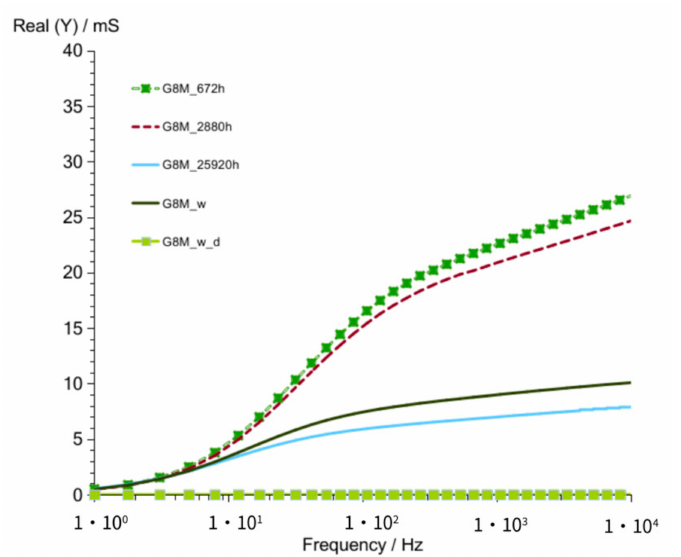
Figure 3. Susceptance of G8M geopolymer concrete taken after 52 do 670 h from starting polymerization.